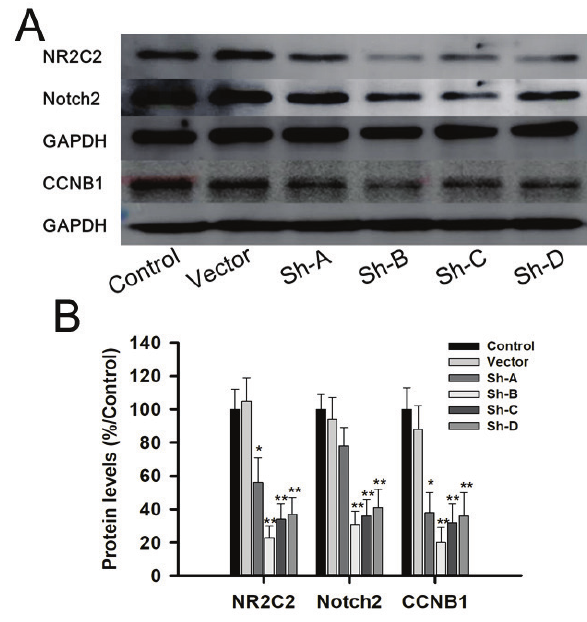
Figure 2: mRNA and protein levels of NR2C2 and Notch2 in prolactinomas. A: The mRNA levels among normal pituitary, IPA and non-IPA. B: Western blot analysis of NR2C2 and Notch2 among normal pituitary, IPA and non-IPA. C: The statistic of western blot. GAPDH was used for normalization. *compared to normal pituitary # compared to IPA, n=4-6. Table 3: The miRNAs levels targeting NR2C2 in prolactinoams.